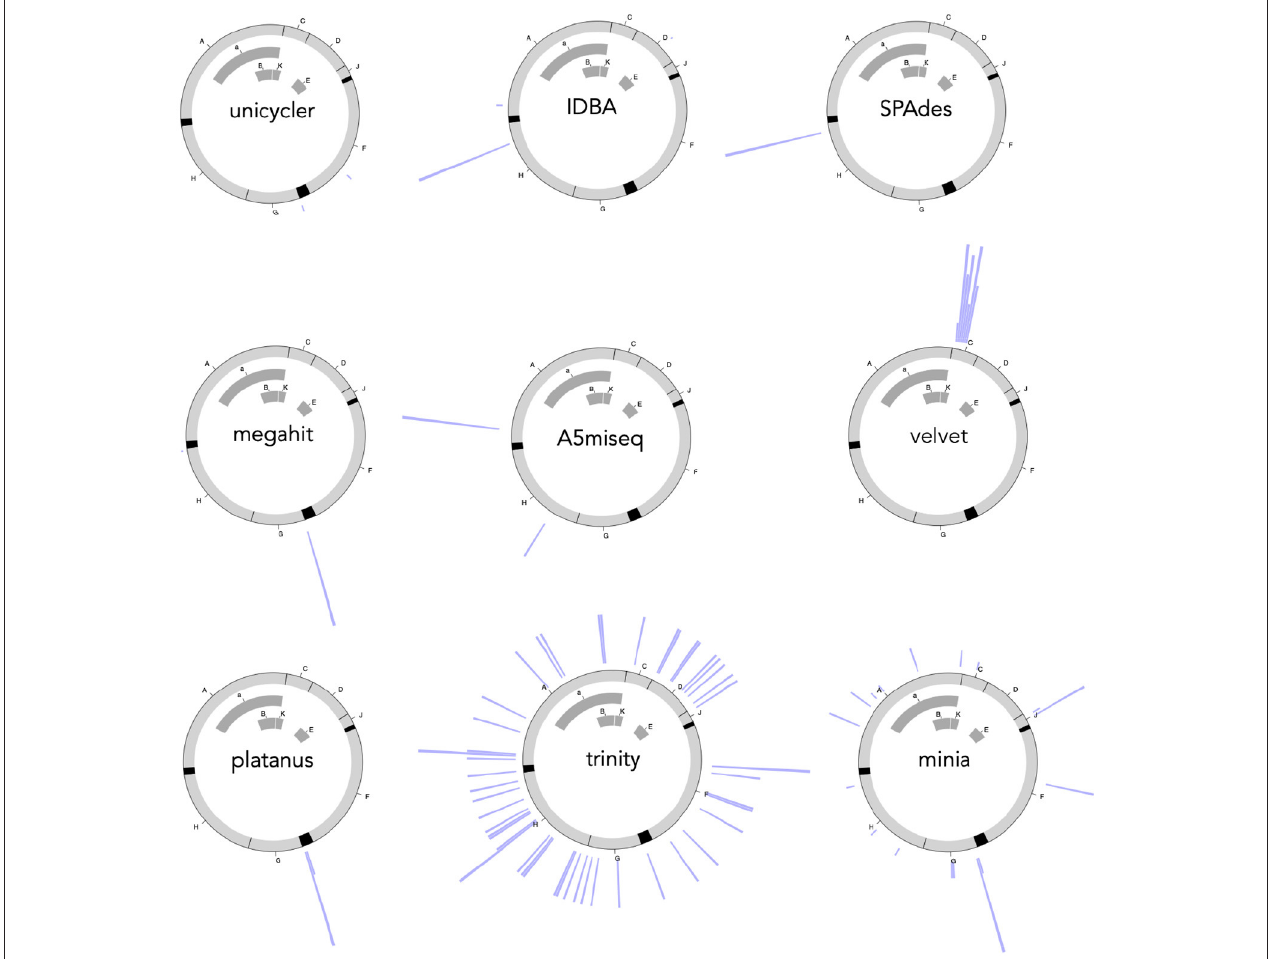
FIGURE 6 | Circular histograms of defect locations on the reference for the nine assembly